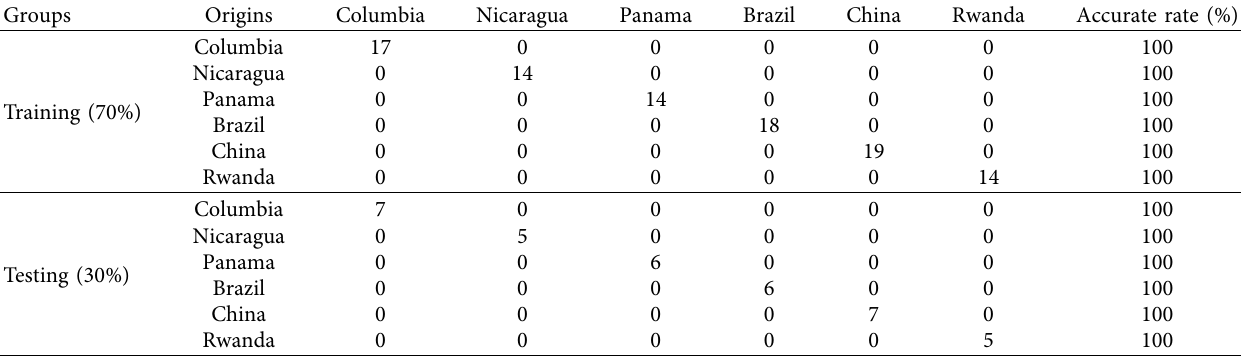
Table 7: Classifcation of 131 middle roasted beans from six diferent regions by RF model.